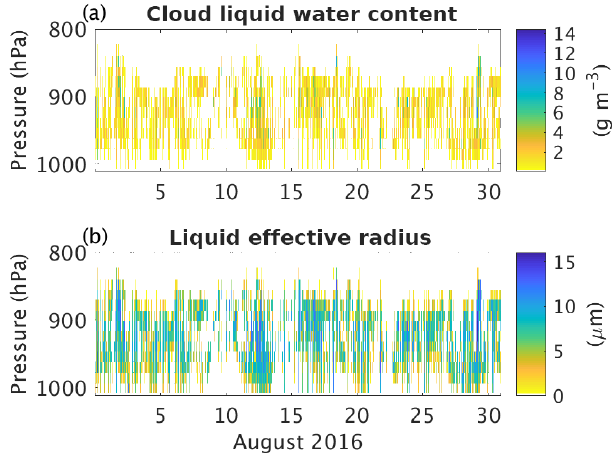
Figure 7. (a) Cloud water content and (b) liquid effective radius over Ascension Island during August 2016 as calculated by the MI- CROBASE